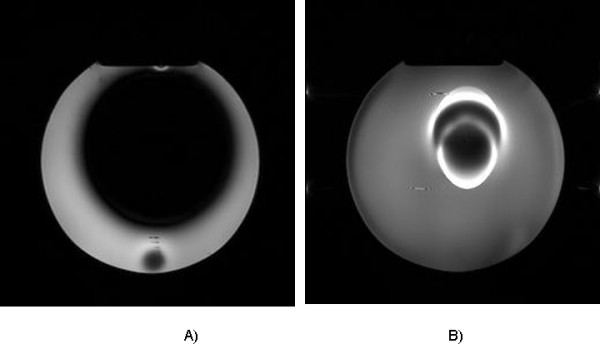
Artifact on MR image: The Polaris valve was placed in a water-filled container, with diameter equivalent to adult skull). A) Gradient echo image; B) T1 image.